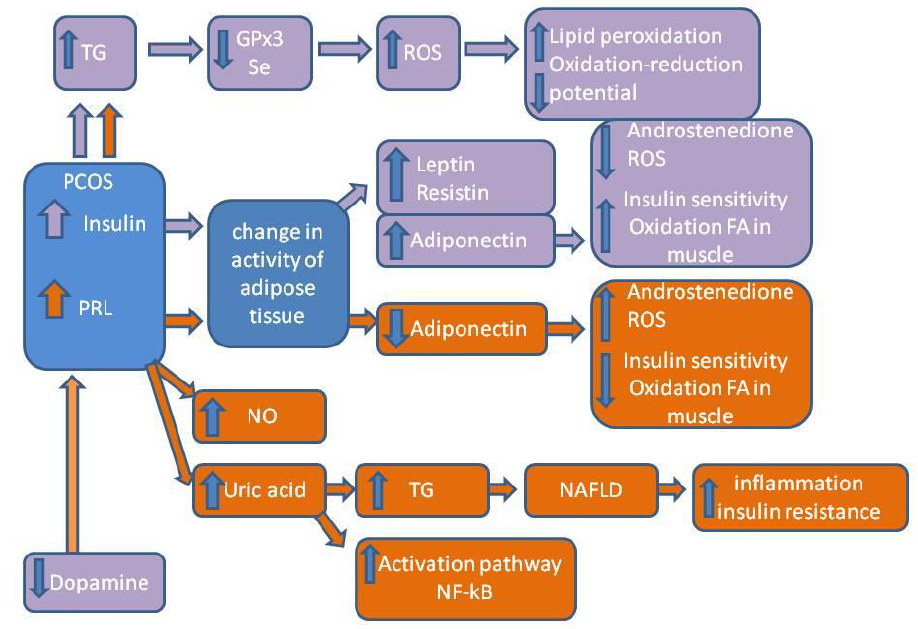
Figure 2. PRL and insulin impact on the development of inflammation involving ROS in PCOS.